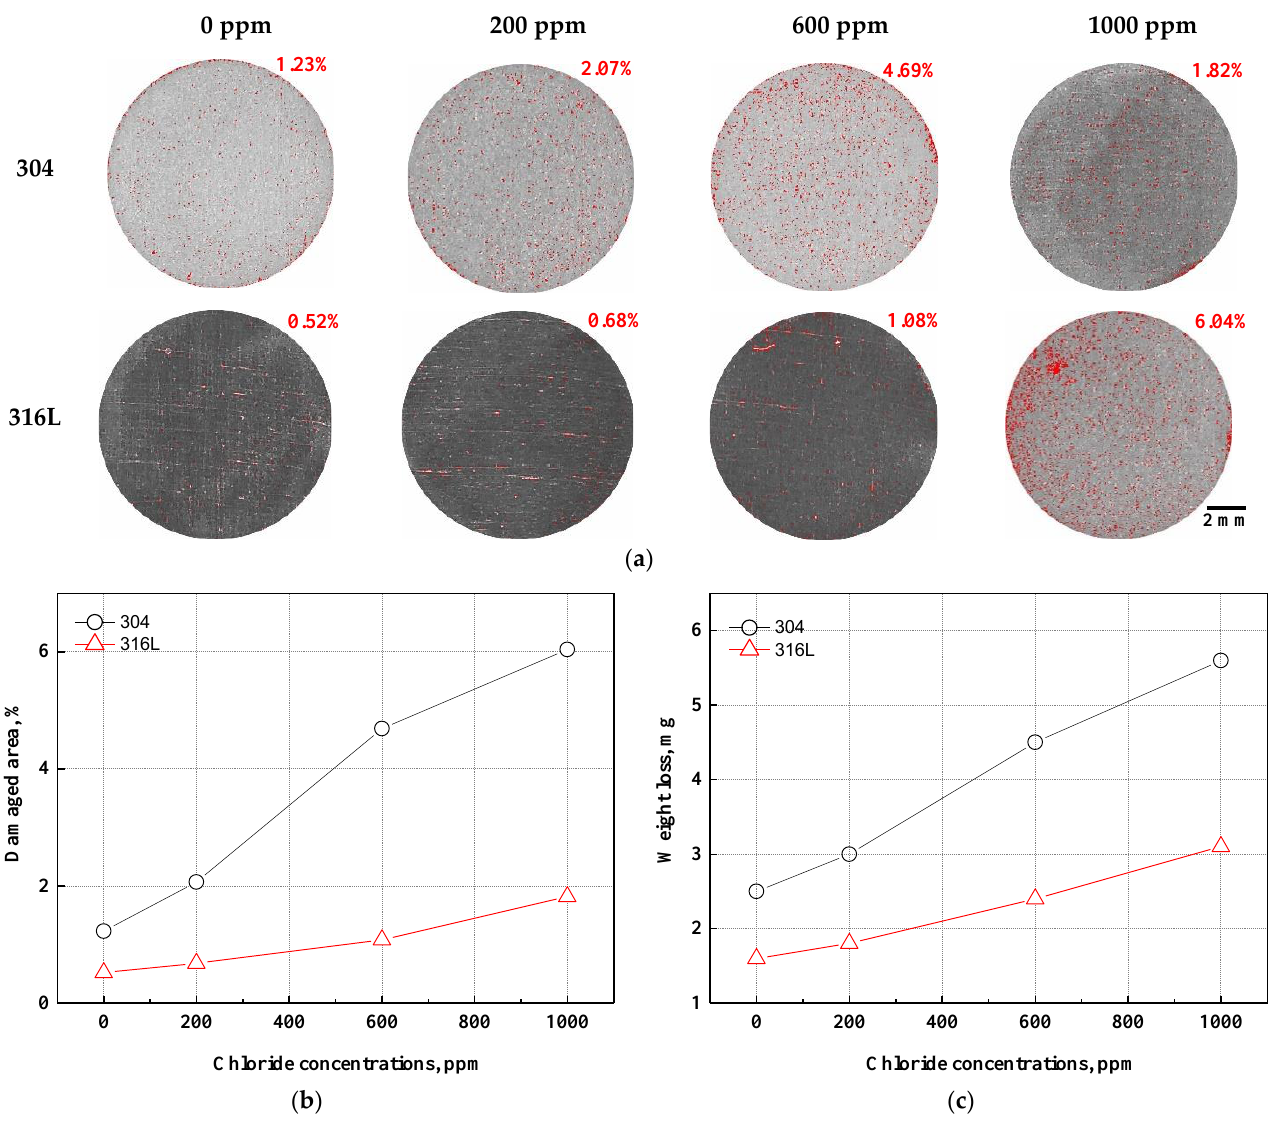
Figure 6. Damaged area and weight loss for 304 and 316L stainless steels after a potentiodynamic polarization experiment: ( a ) result of analysis for damaged area by Image J; ( b ) damaged area; ( c ) weight loss.